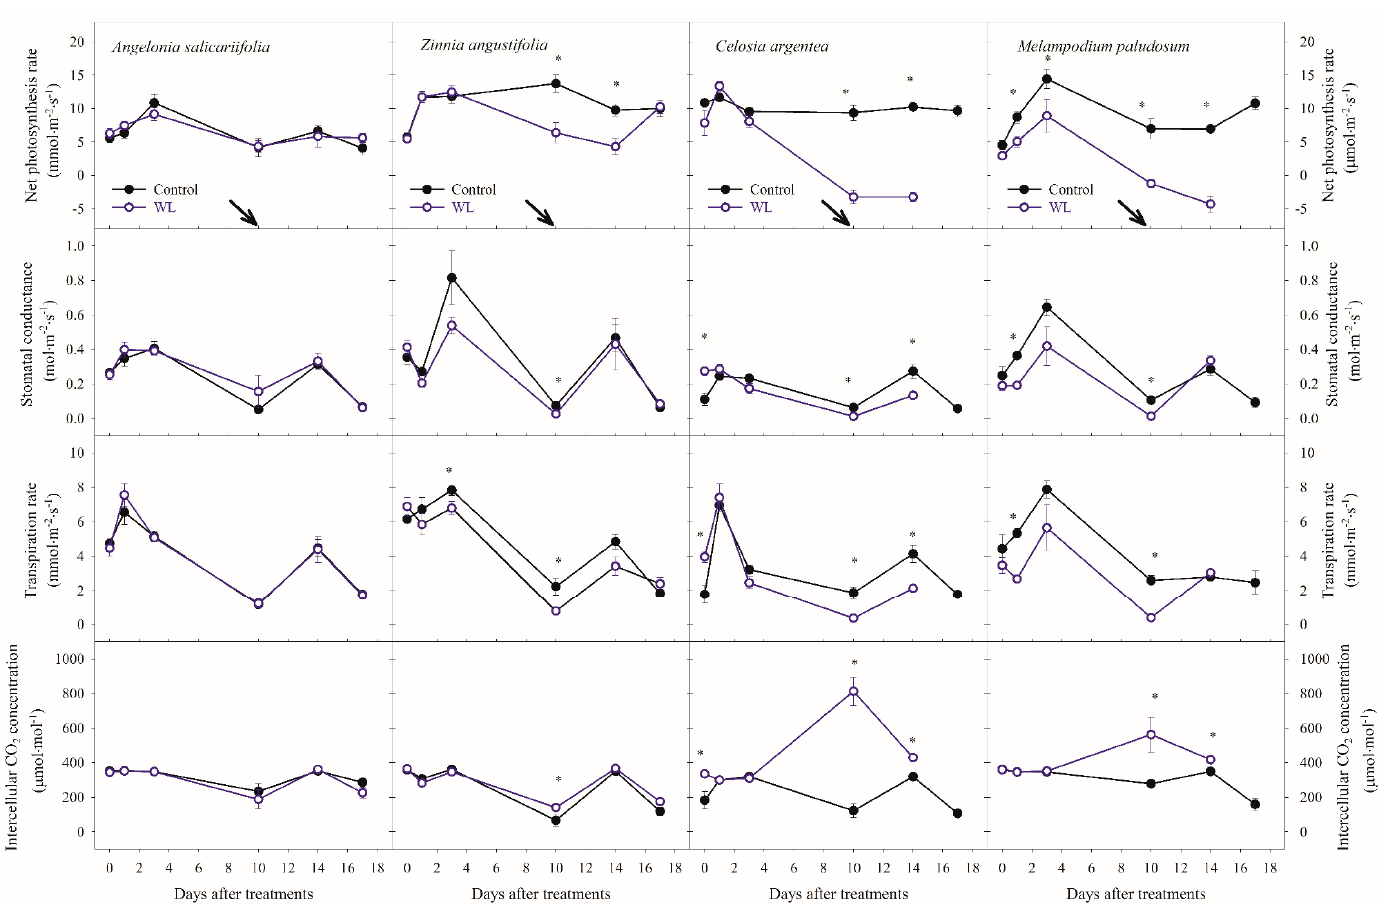
Figure 5. Effects of 10 days of waterlogging followed by a seven-day recovery on net photosynthesis rate ( Pn ), stomatal conductance ( G S ), transpiration rate ( Tr ), and intercellular CO 2 (Ci) of Angelonia salicariifolia , Zinnia angustifolia , Celosia argentea , and Melampodium paludosum . Arrows indicate the beginning of the recovery period from waterlogging. * p < 0.05 between the control and waterlogged (WL) plants by a t -test. Both C . argentea and M . paludosum plants had died by day 17 ( n = 5).